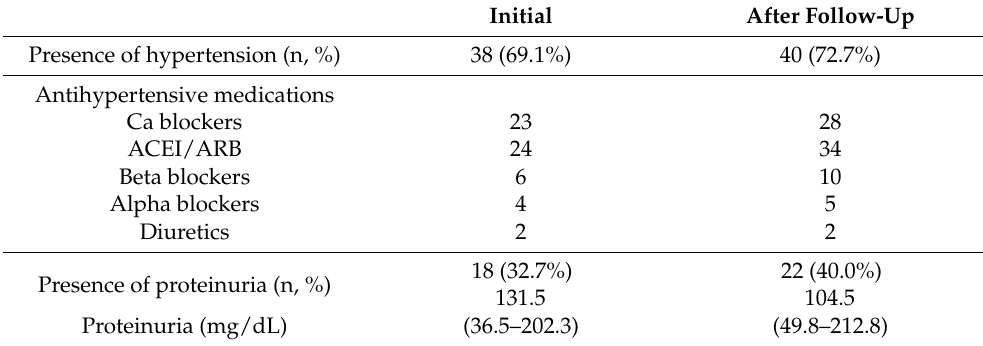
Table 2. Incidence of hypertension and proteinuria at the beginning and after observation.